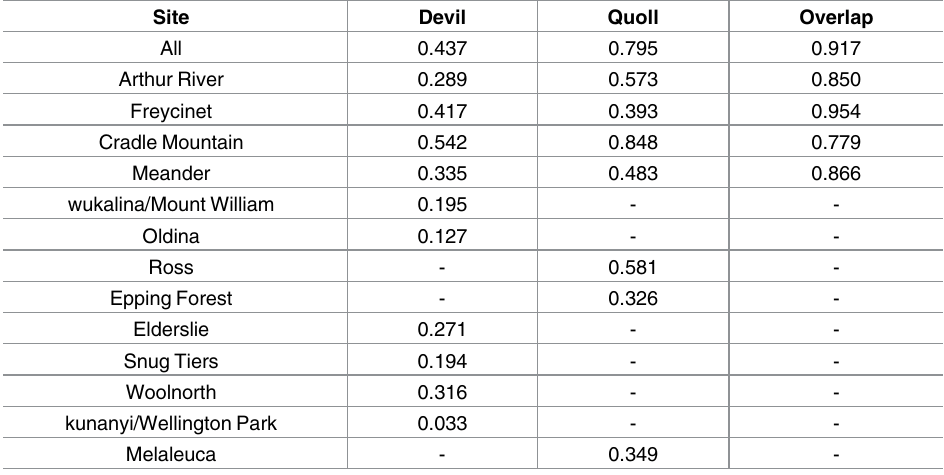
Table 3. Trophic niche breadth (Levins’ index) and diet overlap (Pianka’s index) between Tasmanian devils and spotted-tailed quolls for each site in Tasmania, Australia.